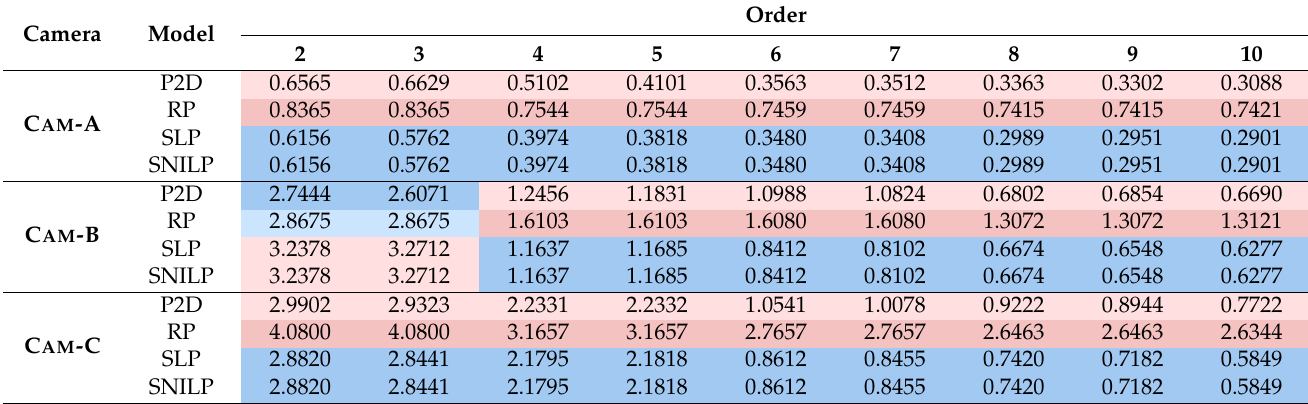
(cid:0) (cid:1) (cid:101) I flat